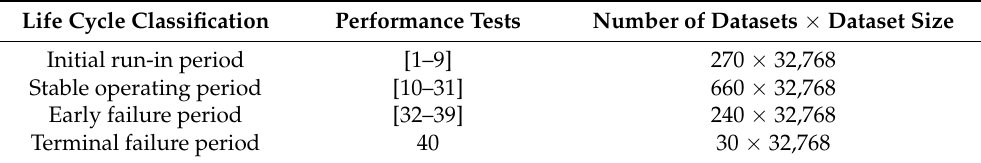
Table 3. Operating periods of the internal gear pump and numbers of samples.